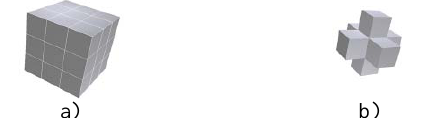
Figure 4. Voxel with a) 26-adjacency and b)